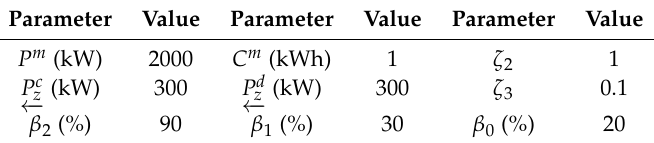
Table 4. Parameters about WESS.